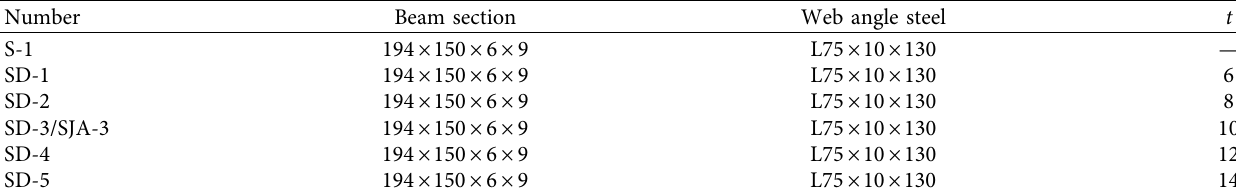
Table 10: Sizes and information of the seat angle model (mm).